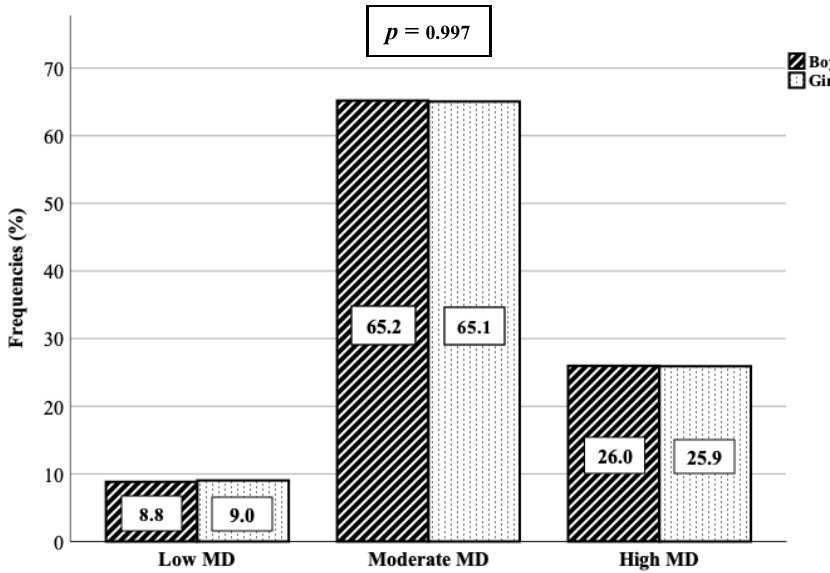
Figure 1. Adherence to the Mediterranean Diet in schoolchildren aged 6–13 in the Region of Murcia (Spain).